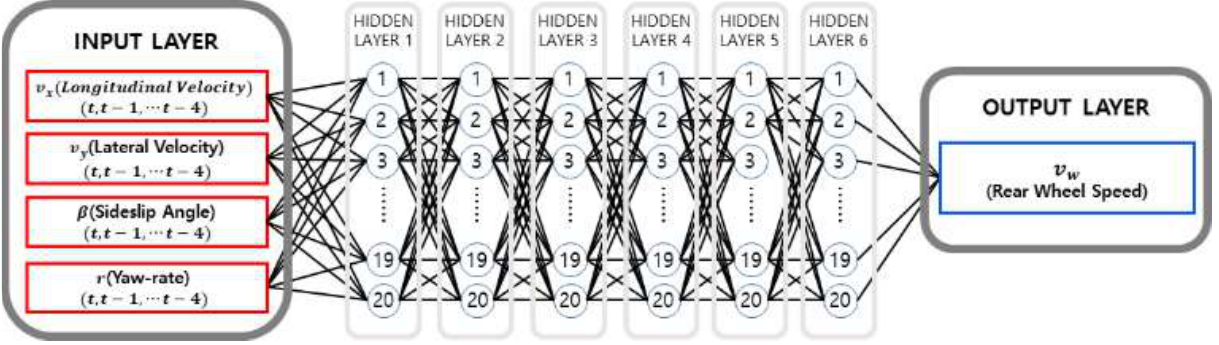
Figure 16. Time delay neural network architecture for drift state control.